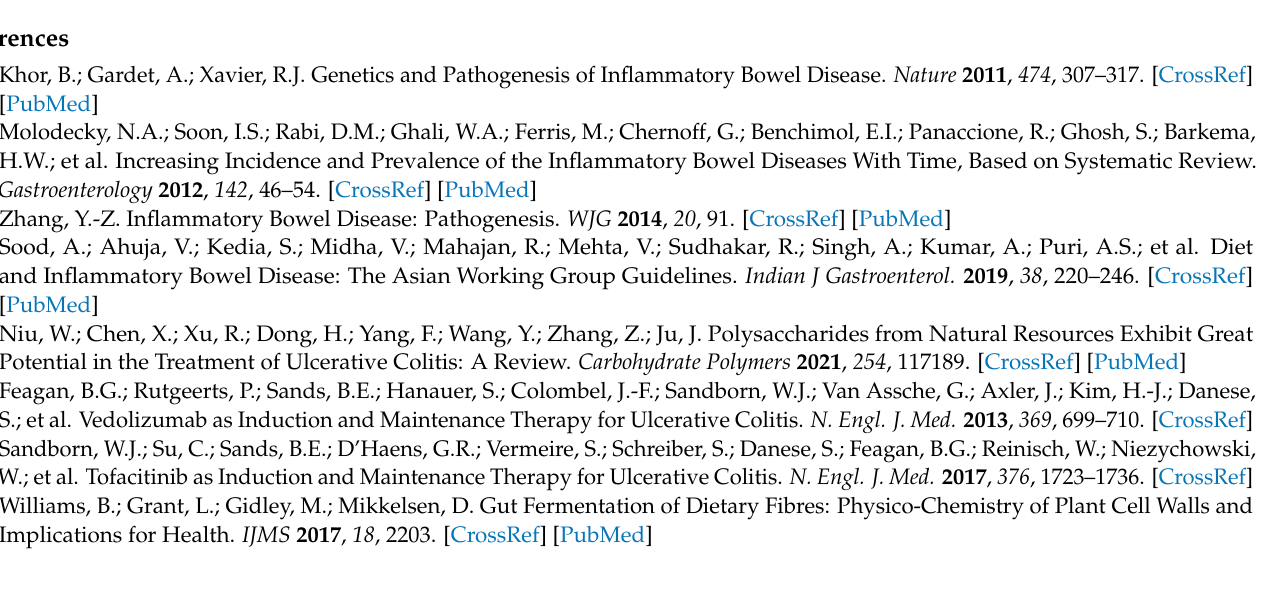
Supplementary Materials: Table S1: Comparison between highland barley and other cereals; Table S2: Composition of experimental